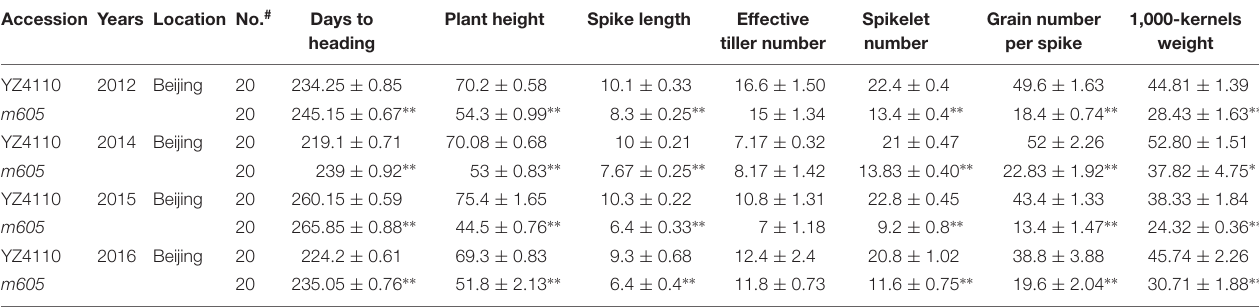
TABLE 1 | The comparison of agronomically important traits in YZ4110 and m605